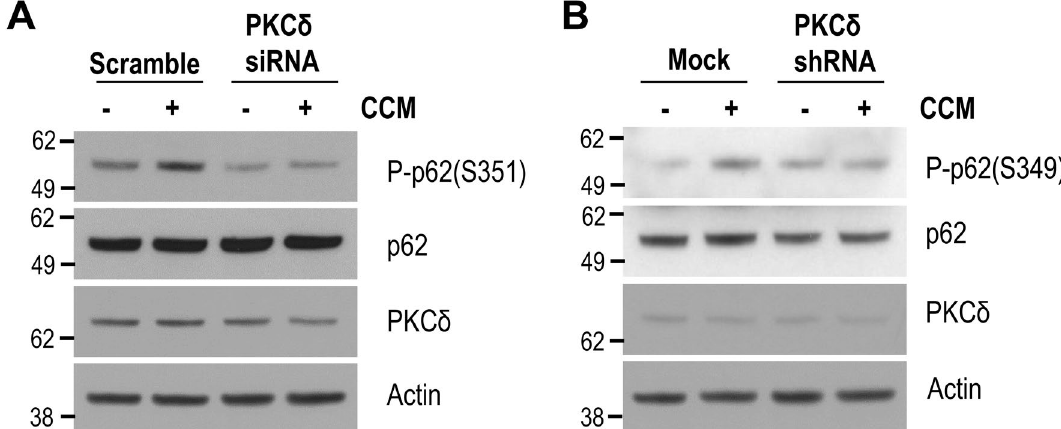
Figure 6. PKCδ is involved in p62 phosphorylation by curcumin. ( A ) Mouse cortical cells were transiently transfected with PKCδ -specific siRNA or scramble RNA as a control. The cells were treated with DMSO (−) or 10 μM curcumin ( +) for 12 h. The levels of phosphorylated p62 (S351), p62, PKCδ, and actin proteins were examined by immunoblotting using anti-phospho p62 (S349), p62, PKCδ, and actin antibodies, respectively. ( B ) HEK293 cells were transiently transfected with PKCδ -specific shRNA expressing plasmid or pcDNA3.1 (Mock), and treated with DMSO (−) or 10 μM curcumin (+) for 12 h. The levels of phosphorylated p62 (S349), p62, PKCδ, and actin proteins were examined by immunoblotting using anti-phospho p62 (S349), p62, PKCδ, and actin antibodies, respectively. Full blots are provided in Supplementary Fig.